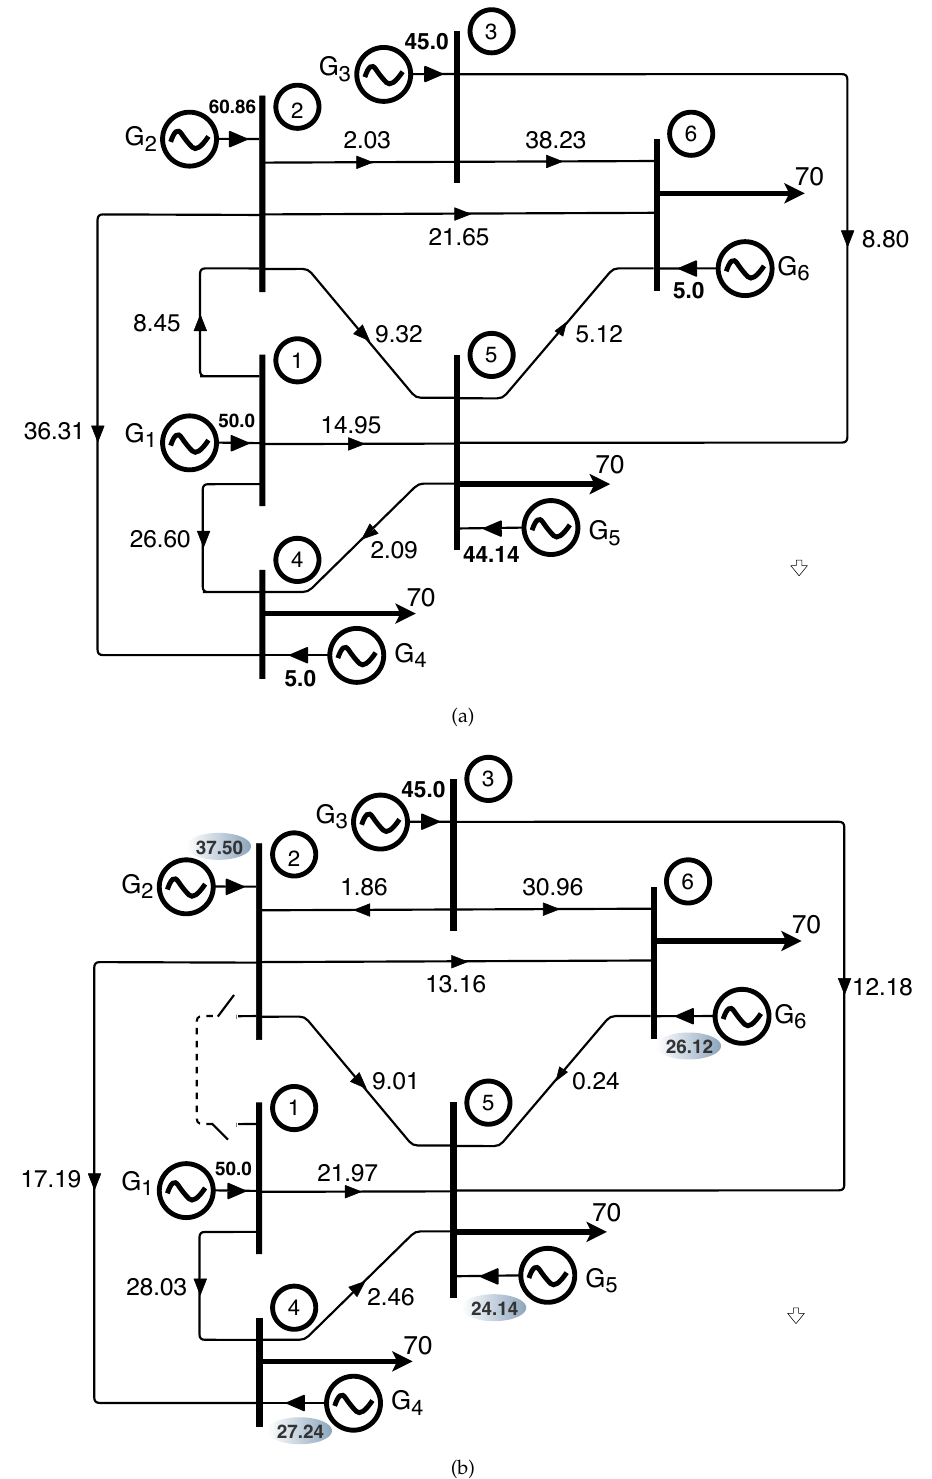
Figure 3. Corrective OPF solution considering the outage of line 1–2. ( a ) Pre-contingency power flow solution. ( b ) Post-contingency power flow